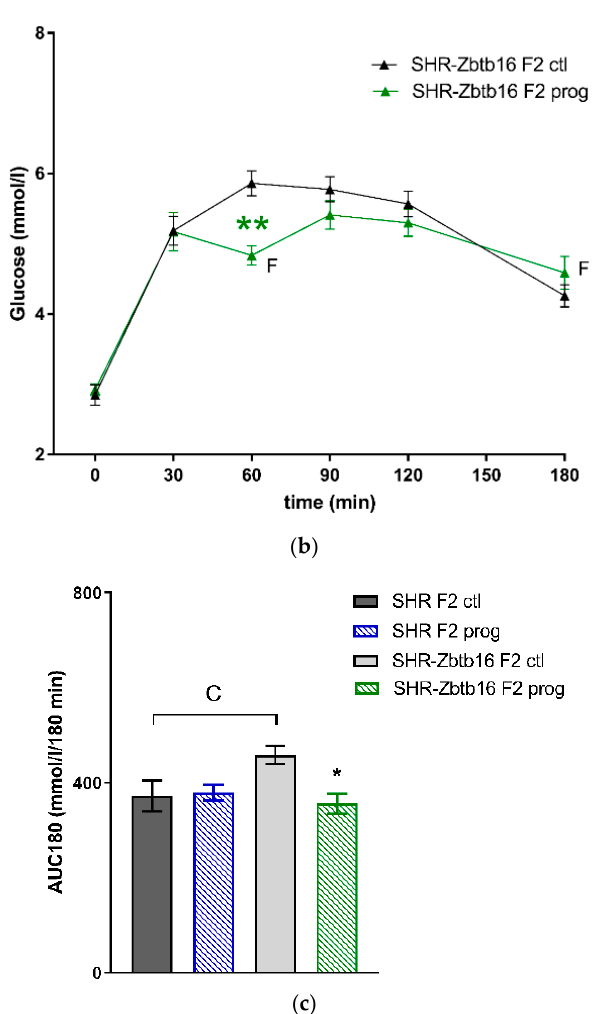
Figure 7. The oral glucose tolerance test (OGTT). The course of glycaemic curves in SHR F2 male offspring (a, control – black circles, programmed – blue circles), SHR-Zbtb16 F2 male offspring (b, control – black triangles, programmed – green triangles) during the oral glucose tolerance test and the corresponding areas under the glycaemic curves (c, AUC180). Data are expressed as mean ± SEM. The strain comparison using the post-hoc Fisher’s least significant difference test of the two-way ANOVA for STRAIN and PROGRAM as major factors are indicated as follows: * p < 0.05, ** p < 0.01, *** p < 0.001. Effect of programming in SHR and SHR-Zbtb16 strains is represented by blue and green asterisks (*), respectively. ( a ) C represents STRAIN differences between F2 SHR and SHR-Zbtb16 control males, t = 0 min CCC p < 0.001, t = 30 min C p < 0.05, t = 180 min C, which were all higher in SHR F2 control males. ( b ) F represents STRAIN differences between F2-programmed SHR and SHR- Zbtb16 males, t = 60 min *, t = 180 min *, which were both higher in SHR F2-programmed males; ( c ) C represents STRAIN differences between F2 SHR and SHR-Zbtb16 control males, AUC180 C p < 0.05, higher in SHR-Zbtb16 F2 control males.